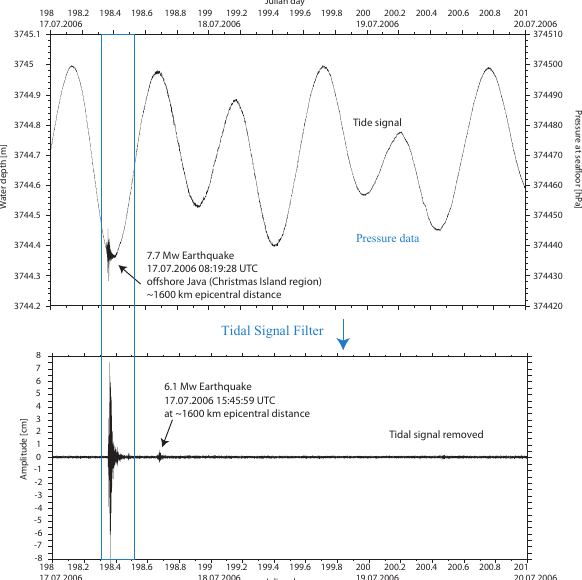
Fig. 21. Example of pressure data recorded by OBU-01b located at 0 ◦ 25.515 0 S/96 ◦ 51.658 0 E near location GITEWS 1. Top: raw pressure data; bottom: data after high pass filtering.